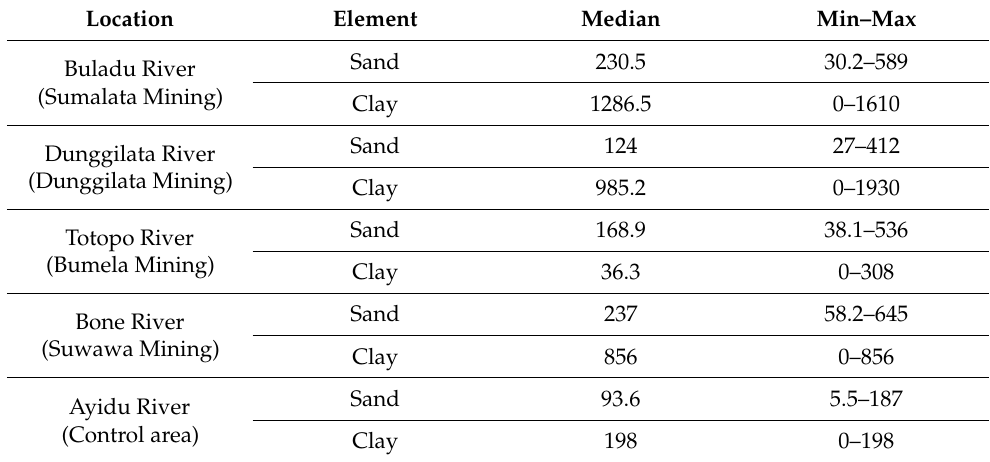
Table 2. Concentration of Pb ( µ g/g) in river sediment sample from ASGM and control area. Location